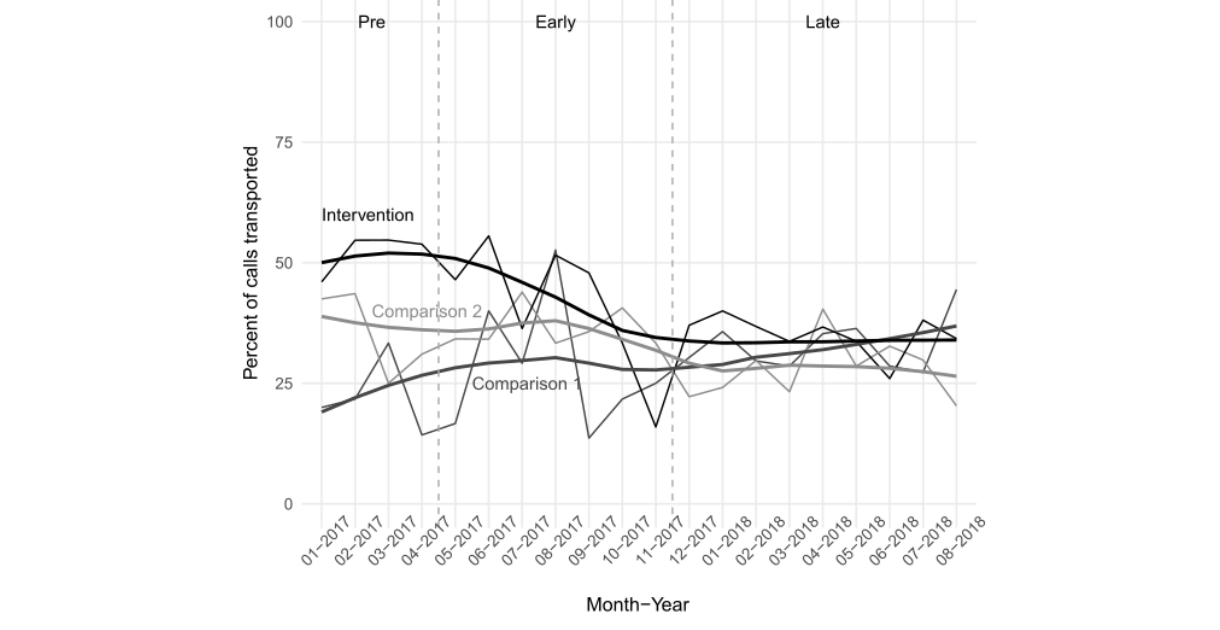
Figure 3. Percentage of calls resulting in transport to the emergency department by ambulance at the intervention and two comparison communities. Dashed vertical lines indicate the demarcations between Pre and Early (ie, the start of telemedicine in May 2017) and between Early and Late (ie, the start of the new telemedicine use policy in December 2017).